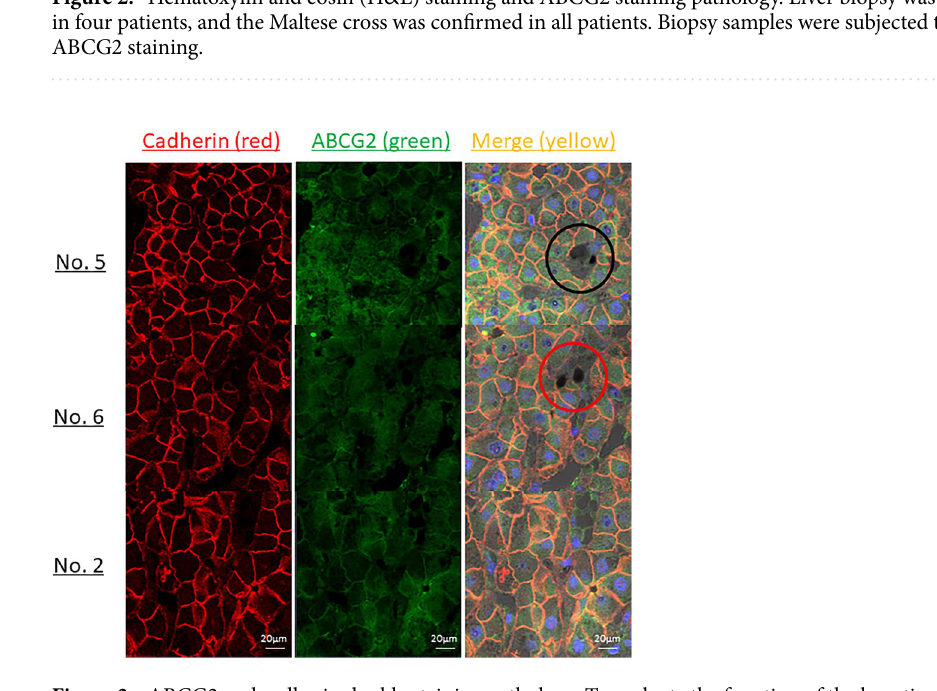
Figure 3. ABCG2 and cadherin double staining pathology. To evaluate the function of the hepatic cell membrane, cadherin staining was performed and double staining with ABCG2 was performed. In No. 5, cadherin (red) was strongly stained in PP-deposited hepatocytes, but ABCG2 (green) was weakly stained (black circles). In No. 6, both the staining properties of ABCG2 (green) and cadherin (red) were decreased in PP-deposited hepatocytes (the part indicated by the red circle). On the other hand, in No. 2, the stainability of ABCG2 and cadherin was